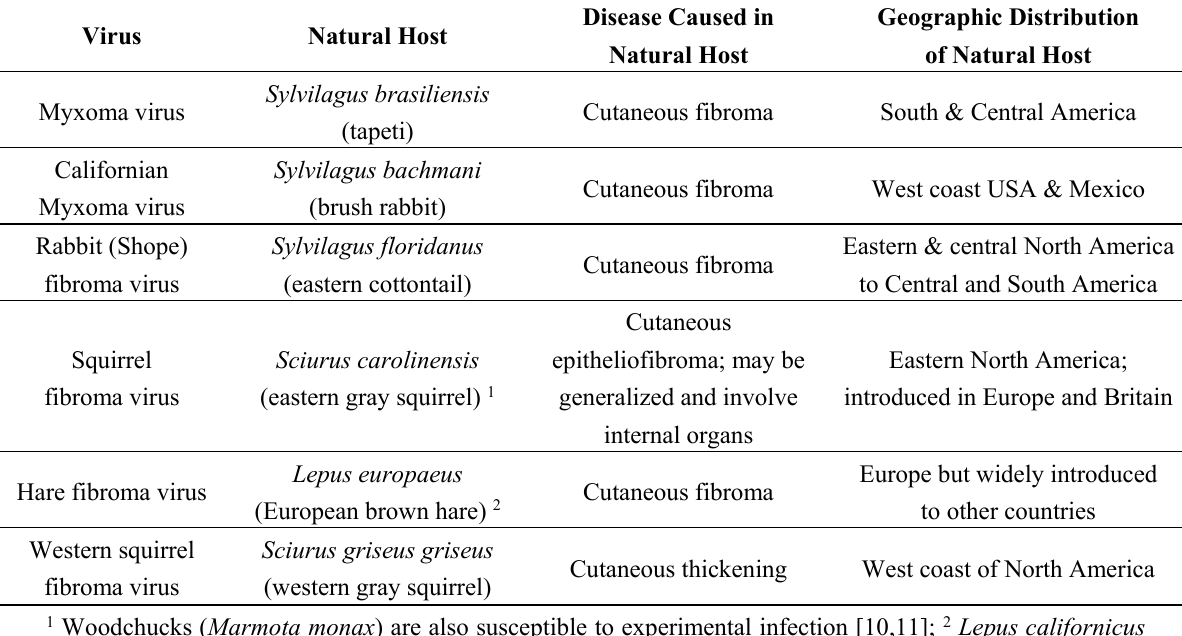
Table 1. The leporipoxviruses